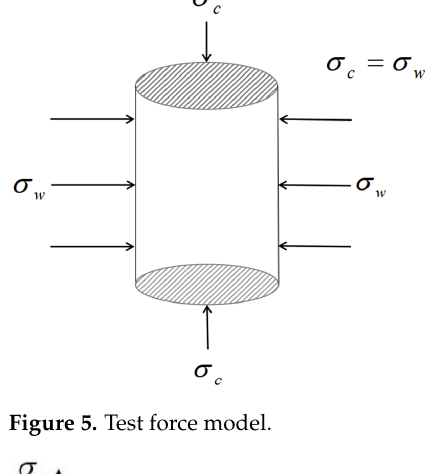
Figure 5. Test force model.